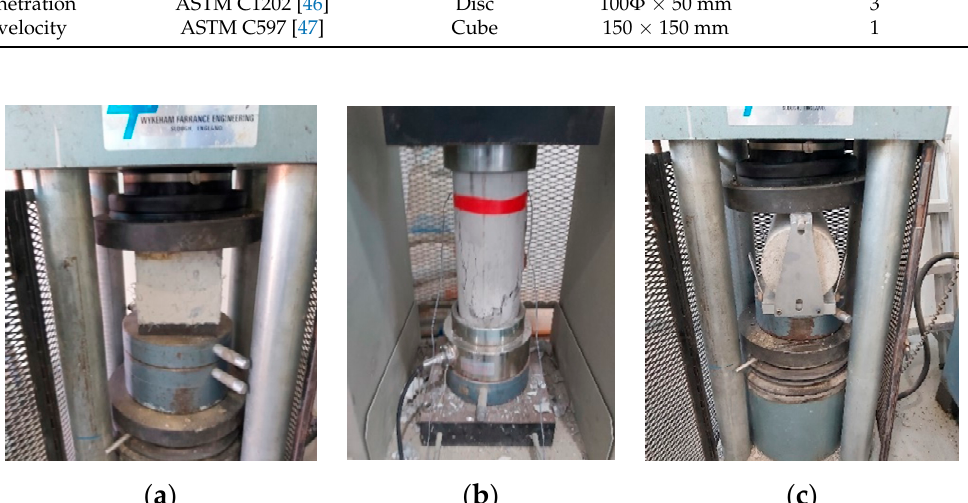
Figure 3. Typical mechanical tests in progress: ( a ) cube compression test; ( b ) cylinder compression test; ( c ) splitting tensile test.